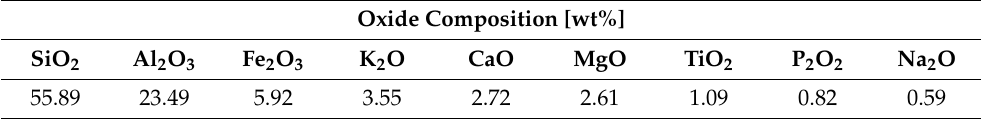
Table 1. Fly ash oxide composition.